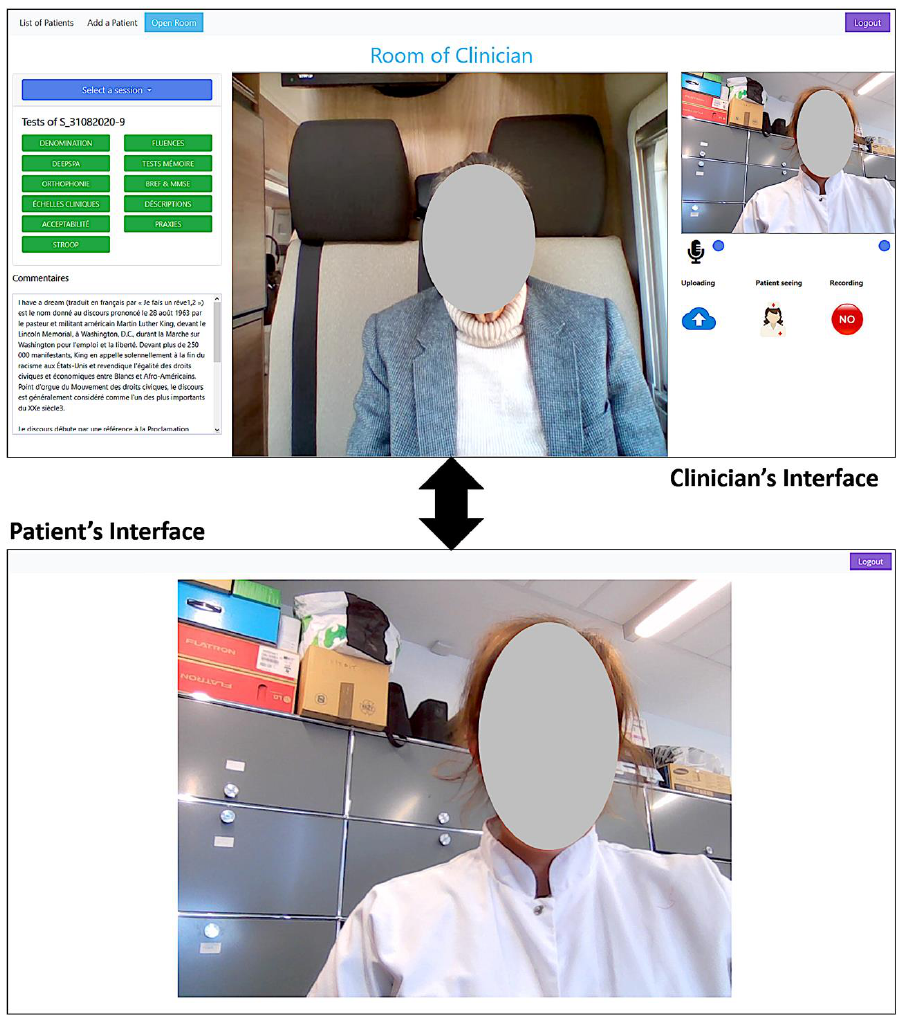
Figure 1. View of both the clinician’s and patient’s interfaces. The clinician’s interface allows several capabilities of controlling and sharing visual content (images and texts). The patient’s interface is simplified to make it easy to use for older people not used to computers. For some clinical tests, the possibility is given to the participant, when they are used to computers, to interact with the system (click on buttons, check boxes, or select images).